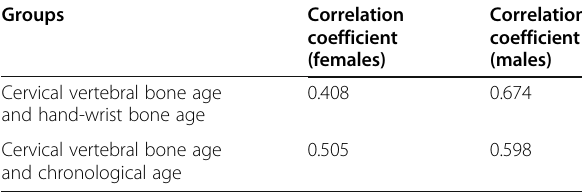
Table 4 Extent of correlation between different ages Groups Correlation